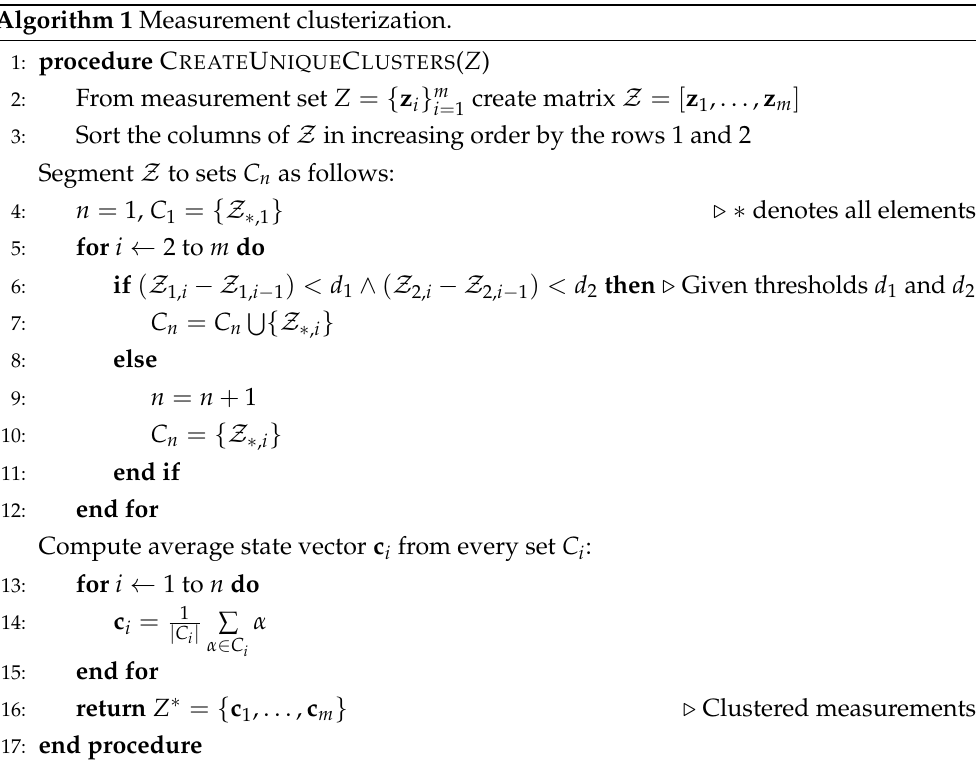
Algorithm 1 Measurement